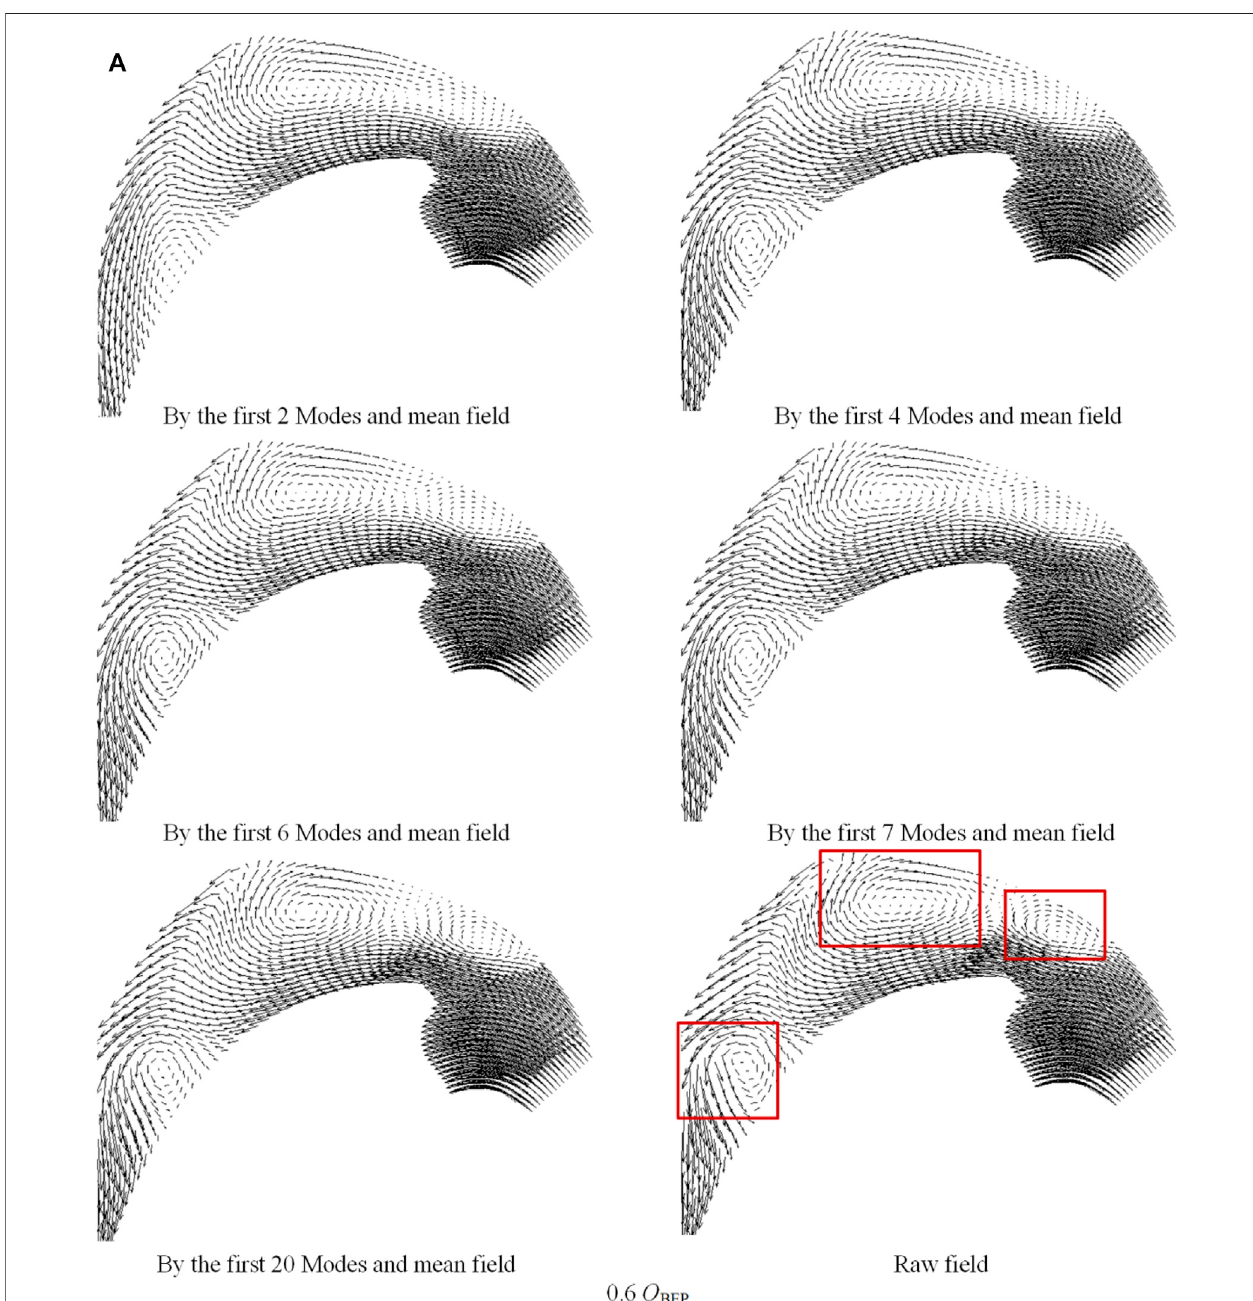
FIGURE 15 | Comparison of vector plots between the raw and reconstructed fi elds. (A) 0.6 Q BEP , (B) 1.0 Q BEP.